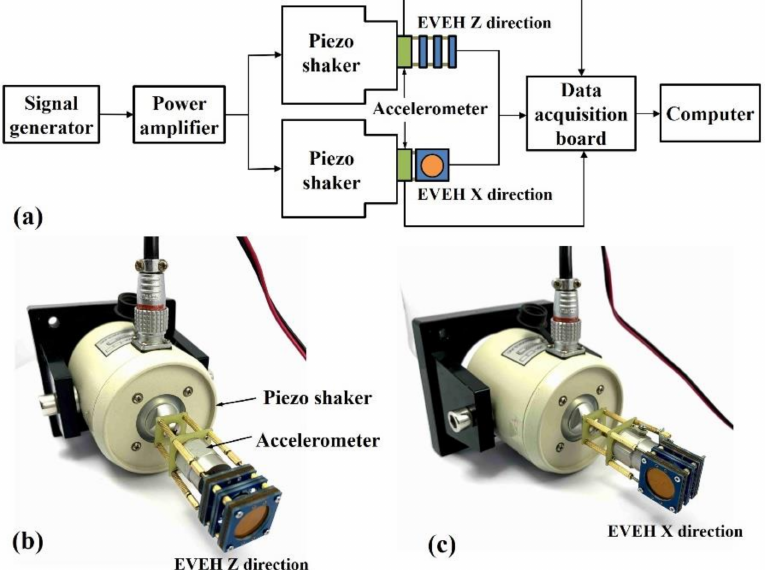
Figure 5. ( a ) Schematic illustration of the setup for characterizing the EVEH device; ( b ) photo of the Z direction measurement setup; and ( c ) photo of the X direction measurement